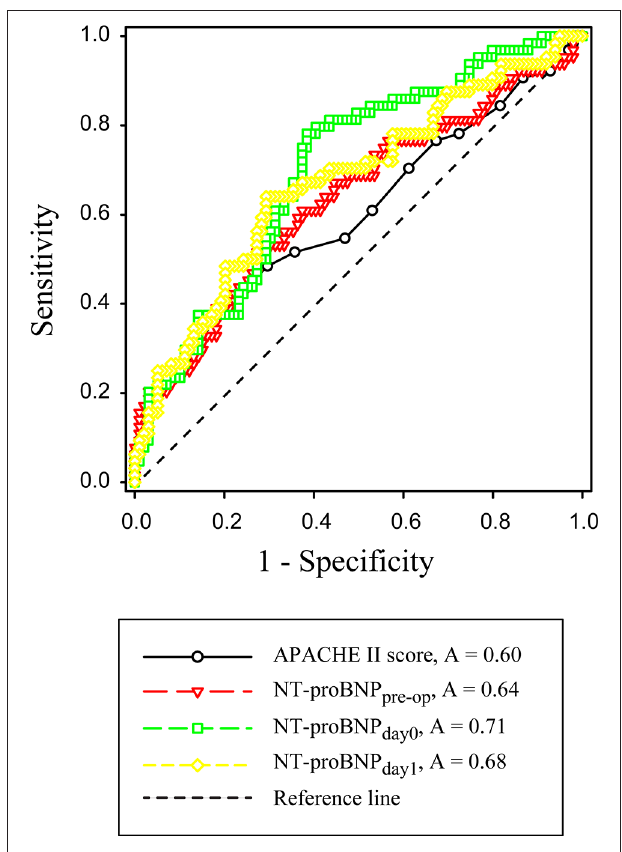
FIGURE 2 | Receiver operating characteristic curves for APACHE II score, NT-proBNP pre − op , NT-proBNP day0 and NT-proBNP day1 . APACHE-II, Acute Physiology and Chronic Health Evaluation II; NT-proBNP pre − op , preoperative